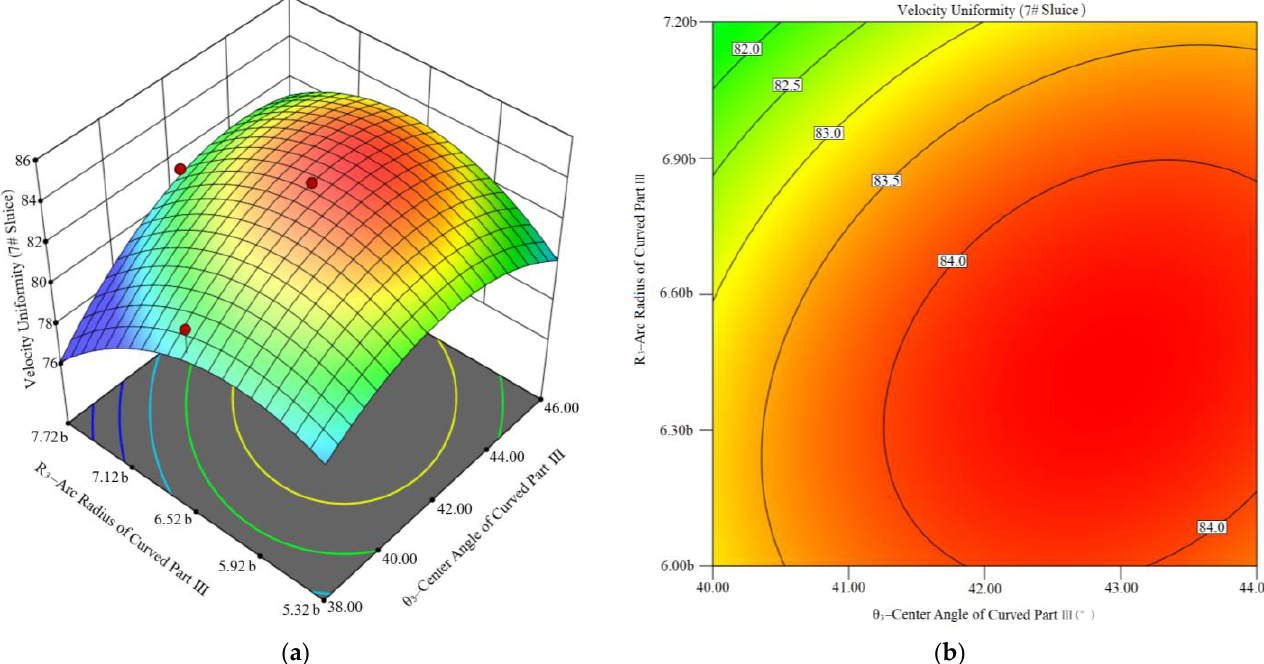
Figure 12. Three-dimensional effect diagram and contour map (operational state of free-draining): ( a ) three-dimensional effect diagram; ( b ) three-dimensional contour map.